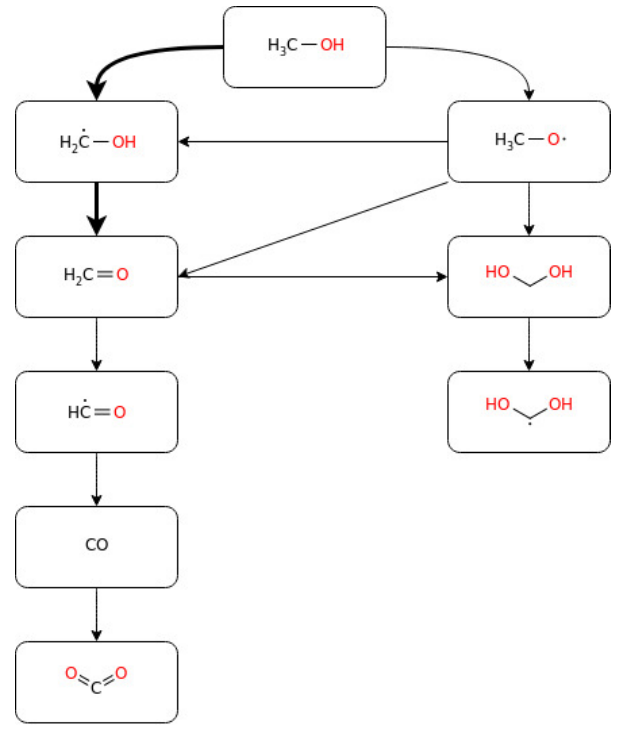
Figure 2. Simplified representation of the reaction paths of methanol in air.